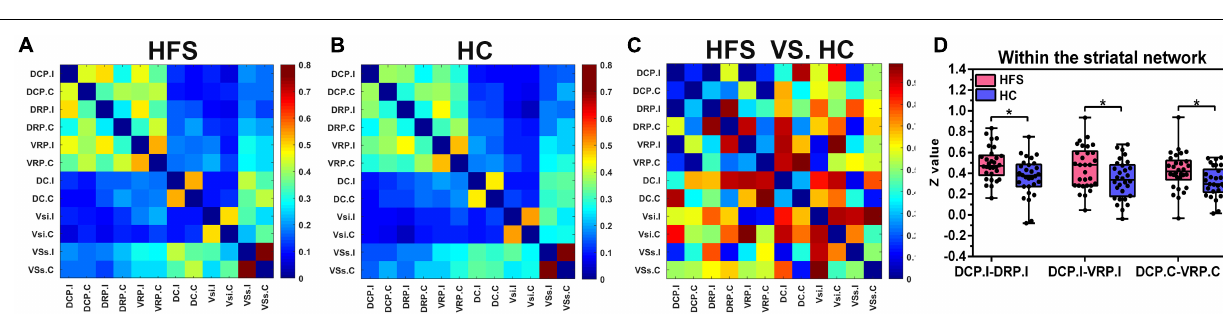
FIGURE 7 | The FC maps of the striatal network. (A) and (B) The FC matrix map of the striatal network in the HFS group and the HC group. The color bar represented the mean z value. (C) The group differences of the FC within the striatal network between the two groups. The color bar represents the P value. (D) In the HFS group compared with the HC group: The ipsilateral DCP showed increased FC with ipsilateral DRP and VRP. In addition, the FC between contralateral DCP and contralateral VRP was increased. * indicates P < 0.05 (uncorrected). FC, functional connectivity; HFS, hemifacial spasm; HC, healthy control; DCP, dorsal caudal putamen; DRP, dorsal rostral putamen; VRP, ventral rostral